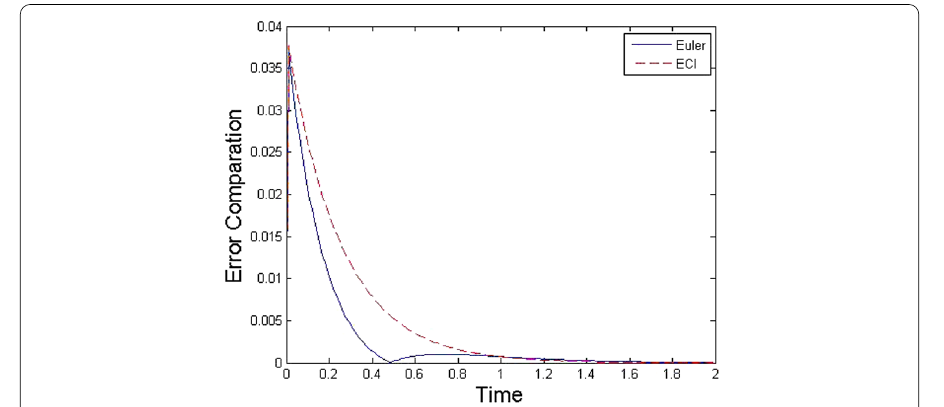
Figure 1 Comparison of the numerical solutions in the time interval [0,2] for two methods